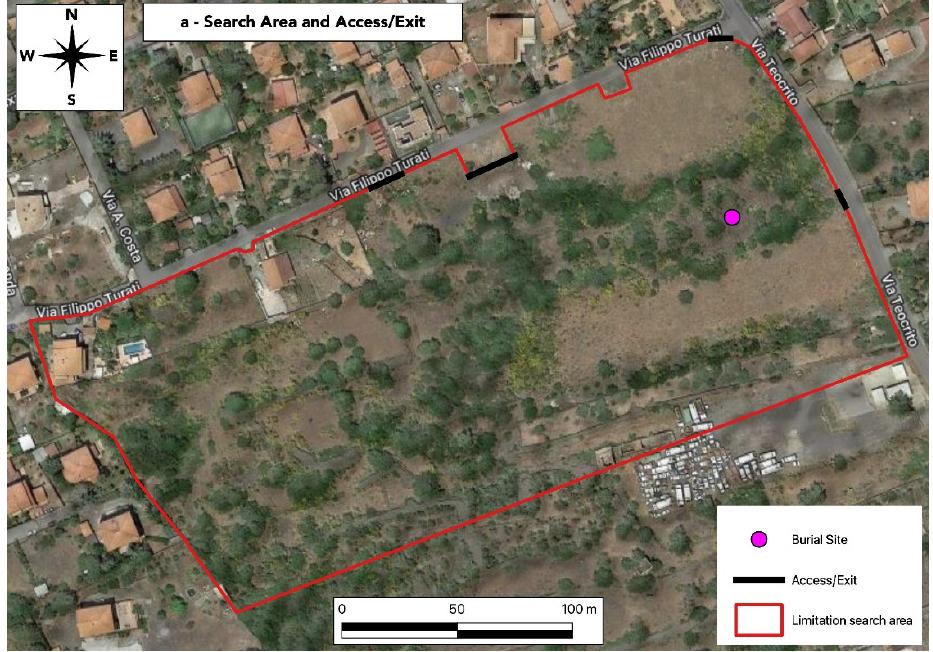
Figure 12. Map of the GIS-based georeferenced layer “Limits and exit-entry points of the search area”. Diggability RAG Map